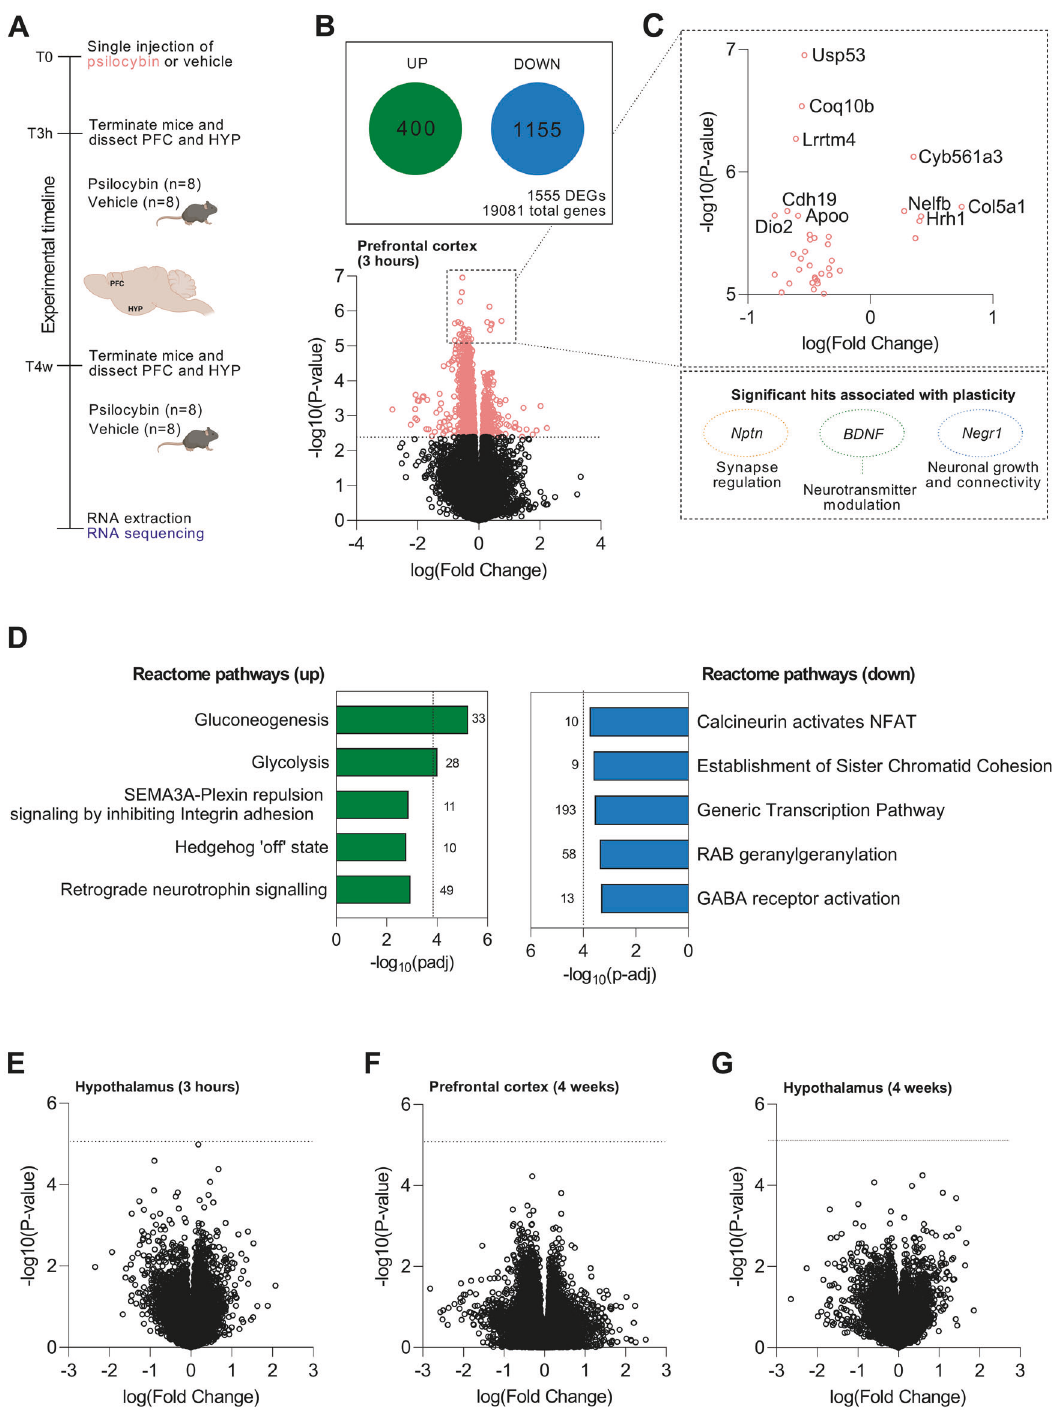
Fig. 4 Acute and chronic hypothalamic and prefrontal cortex (PFC) transcriptomes following a single high dose of psilocybin. A Schematic overview of bulk RNA-seq study. Lean mice were split into two groups and received either a single dose of psilocybin (3 mg/kg) or a vehicle ( n = 16 per group). Three hours following dosing, eight psilocybin-treated and eight vehicle-treated mice were sacri fi ced, and PFC and whole hypothalamus were dissected. The remaining mice were sacri fi ced 4 weeks after injection. B Schematic showing the effect of psilocybin in the PFC 3 h after administration. C Top 10 signi fi cantly differentially expressed genes in PFC (3 h after administration of psilocybin). Points in pink represent genes with p.adj < 0.05. D Reactome pathways for upregulated and downregulated genes in PFC 3 h after administration of psilocybin. E Volcano plot showing the effect of psilocybin in the hypothalamus 3 h after administration of psilocybin vs. vehicle. F Volcano plot showing the effect of psilocybin in PFC 4 weeks after administration of psilocybin vs. vehicle. G Volcano plot showing effect in the hypothalamus for psilocybin-treated versus vehicle-treated mice 4 weeks after administration. Cut off for volcano plots B , E , F , and G calculated as 0.05/19080 number of tested genes.